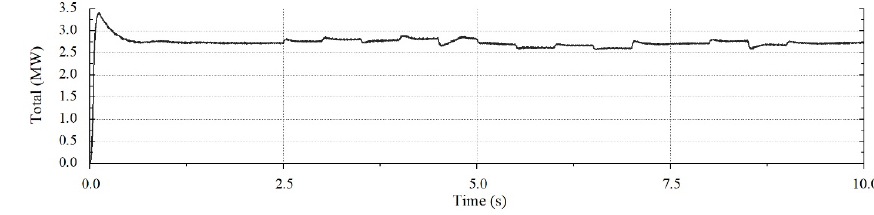
Figure 11. Quantity of power supplied from main grid (ESS ‐ strict voltage control).